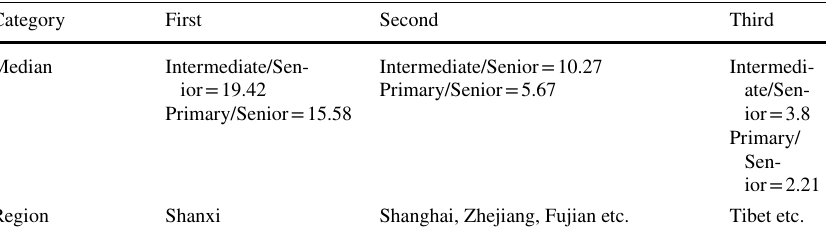
Table 6 Ratio of professional titles of teachers (primary school)